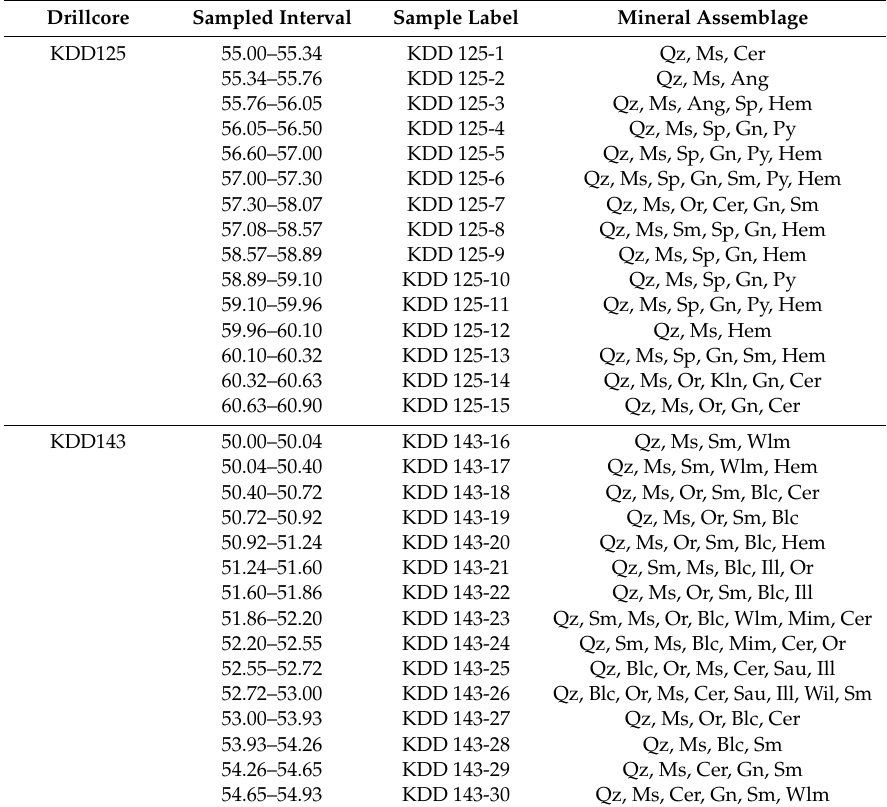
Table 1. List of studied drillcore samples, with mineralogy inferred by qualitative XRPD.